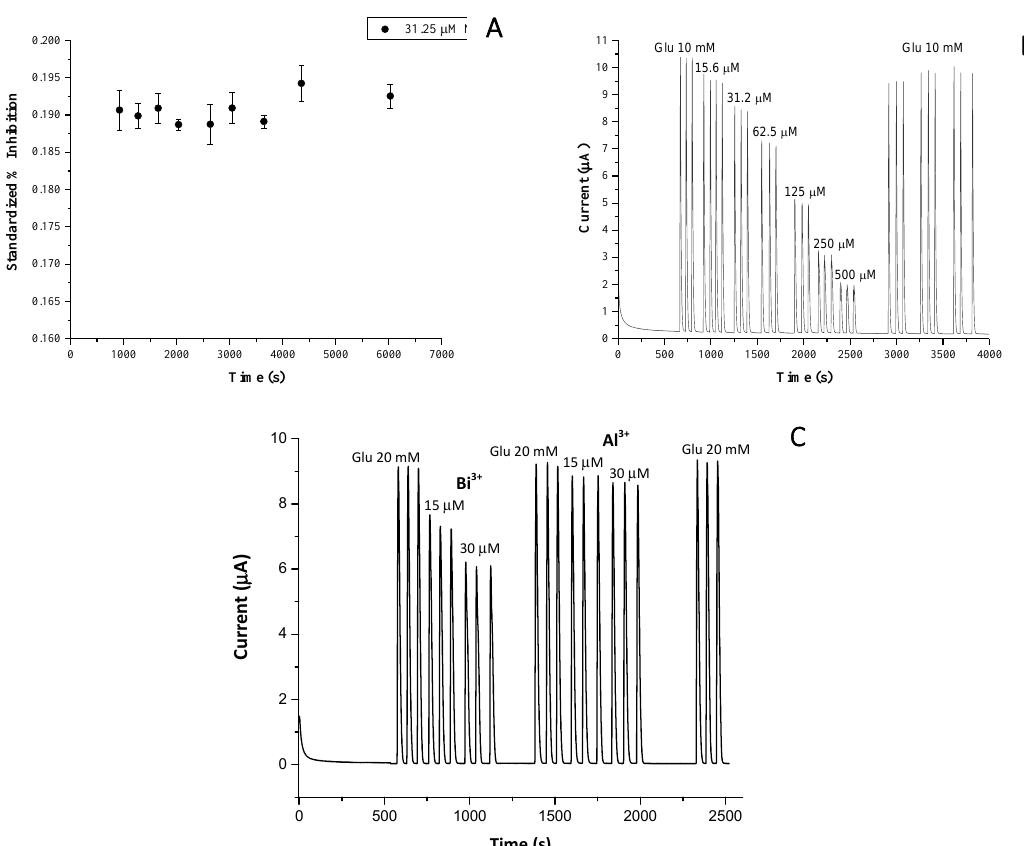
Figure 5. ( A ) Evaluation of working life of biosensor after subsequently injection of 31.25 µ M of Ni 2+ . ( B ) Inhibition effect of Ag + ions and recovery after washing with acetate buffer (50 mM, pH = 5.2). ( C ) Reusability of the biosensor after the injection of 15 µ M and 31.25 µ M of Bi 3+ and Al 3+ ions in presence of 20 mM of glucose and acetate buffer media.